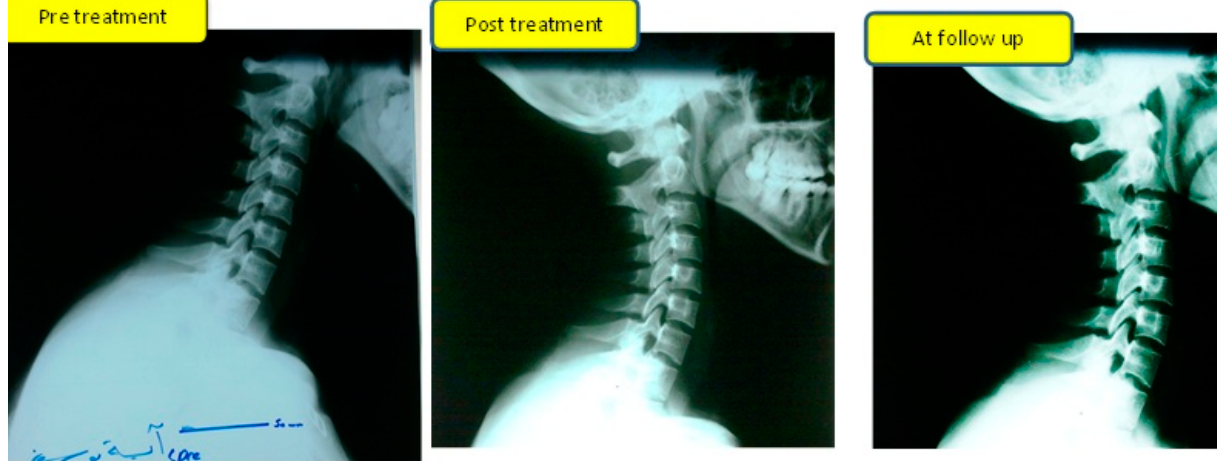
Figure 3. Sample of lateral cervical X ‐ ray findings of a participant in the study group receiving Den ‐ neroll traction application at the three intervals of measurement. Pre ‐ treatment prior to study par ‐ Denneroll traction application at the three intervals of measurement. Pre-treatment prior to study ticipation, 10 ‐ week post ‐ treatment participation, and at the 6 ‐ month study follow up radiographs participation, 10-week post-treatment participation, and at the 6-month study follow up radiographs are shown demonstrating improved cervical lordosis and reduced anterior head posture. are shown demonstrating improved cervical lordosis and reduced anterior head